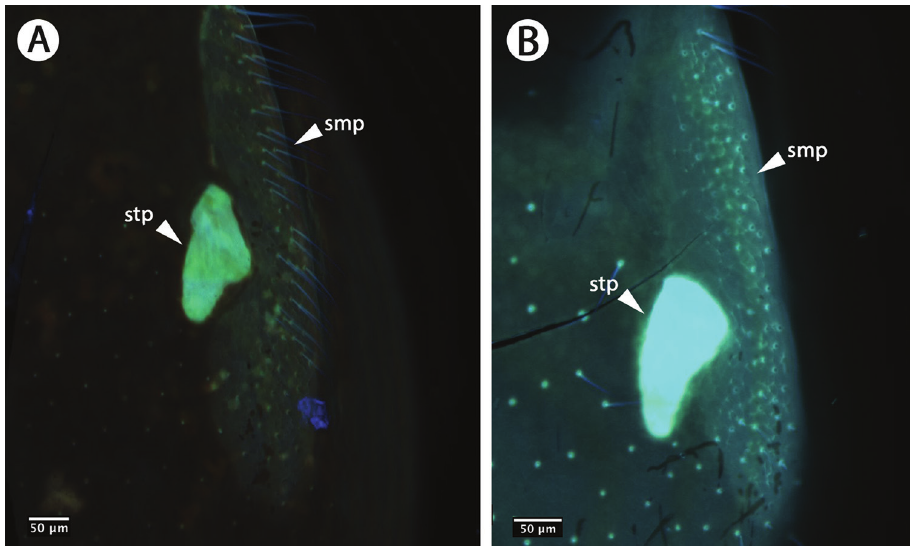
Figure 7. CLSM image of the synsternal translucent patch and setiferous patch in a male ( A identifier: PSUC_FEM 86236) and female ( B identifier PSUC_FEM 86240) Megaspilus armatus Say, 1836 speci- men (Hymenoptera: Megaspilidae), viewed externally. Abbreviations: smp = synsternal setiferous patch; stp = synsternal translucent